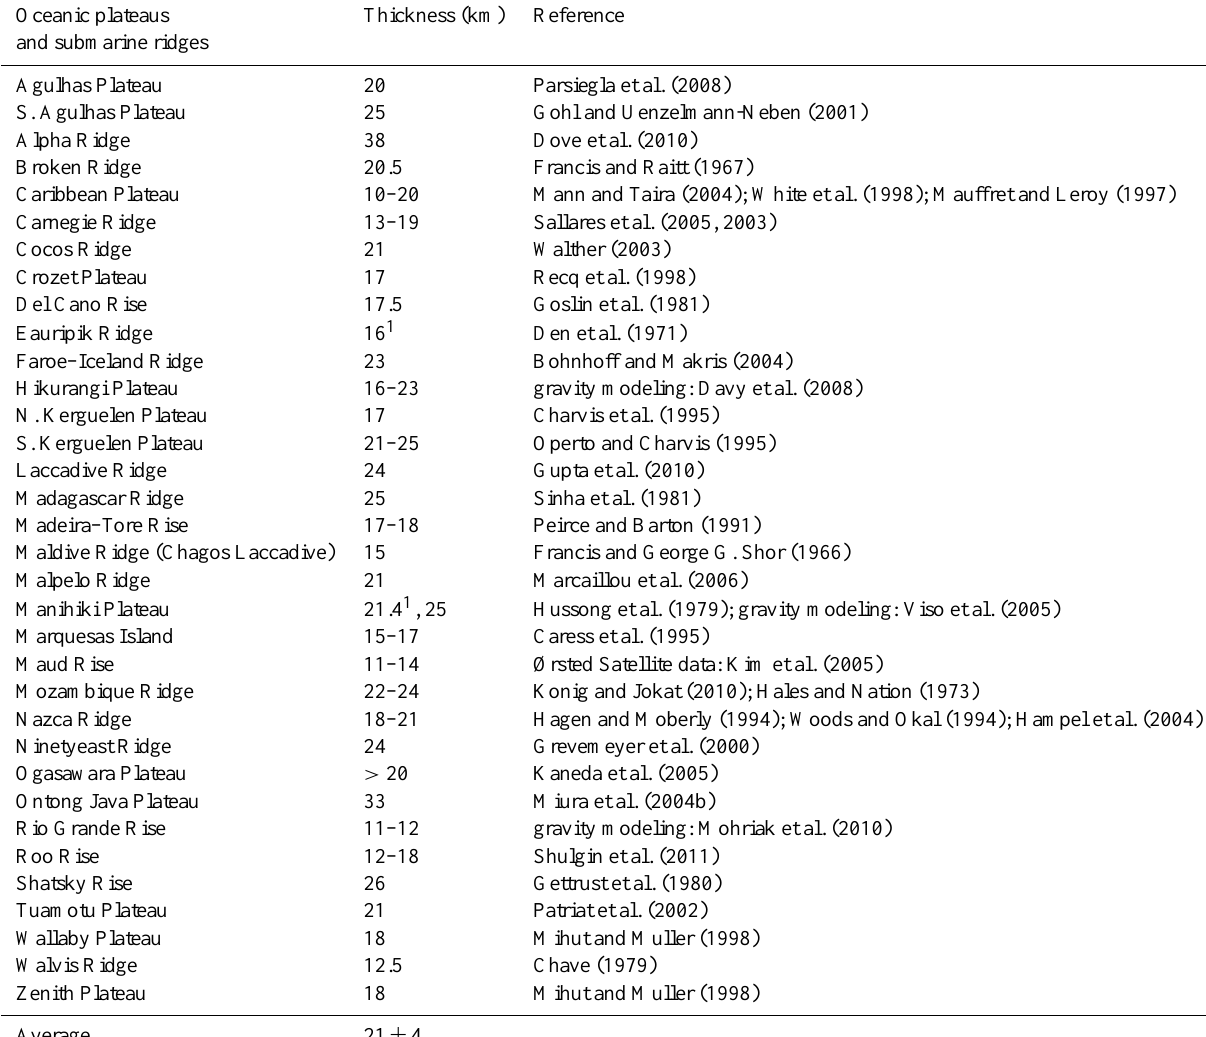
Table 3. Crustal thicknesses of oceanic plateaus and submarine ridges. Thicknesses are derived from seismic studies unless otherwise noted. 1 The crustal thickness was extrapolated in the original study because the Moho was not